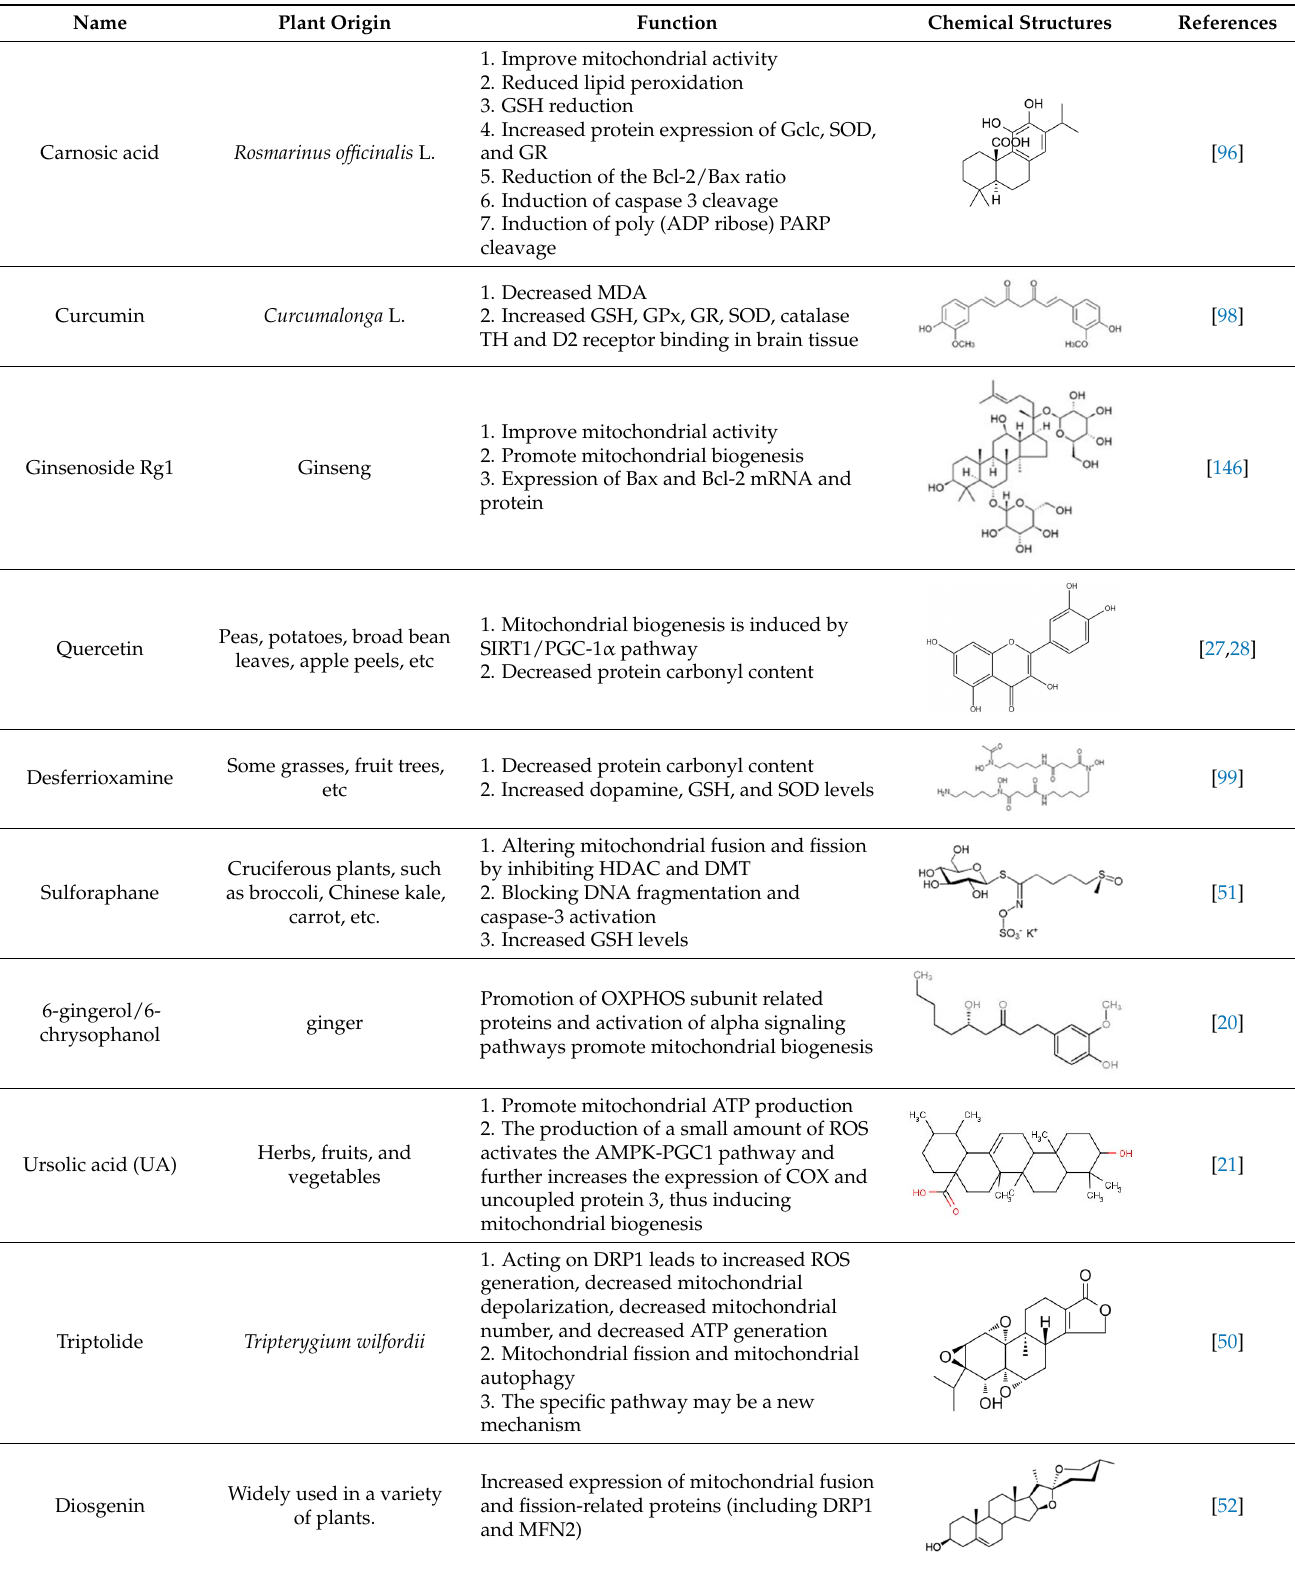
Table 1. Summary of plant active ingredients effective on neurodegenerative disease.